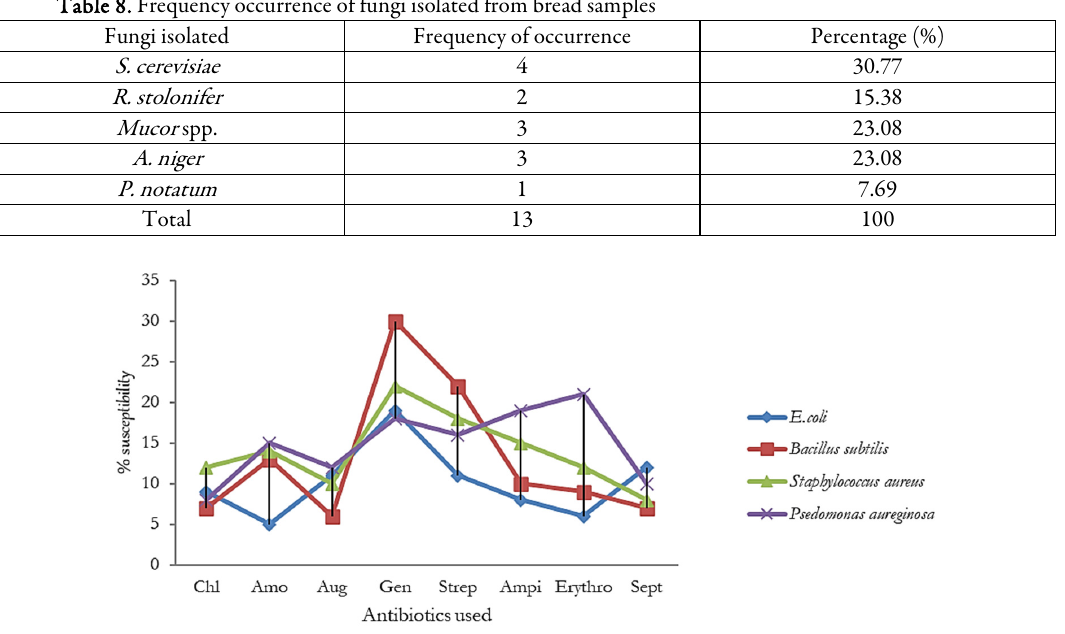
Table 8. Frequency occurrence of fungi isolated from bread samples Fungi isolated